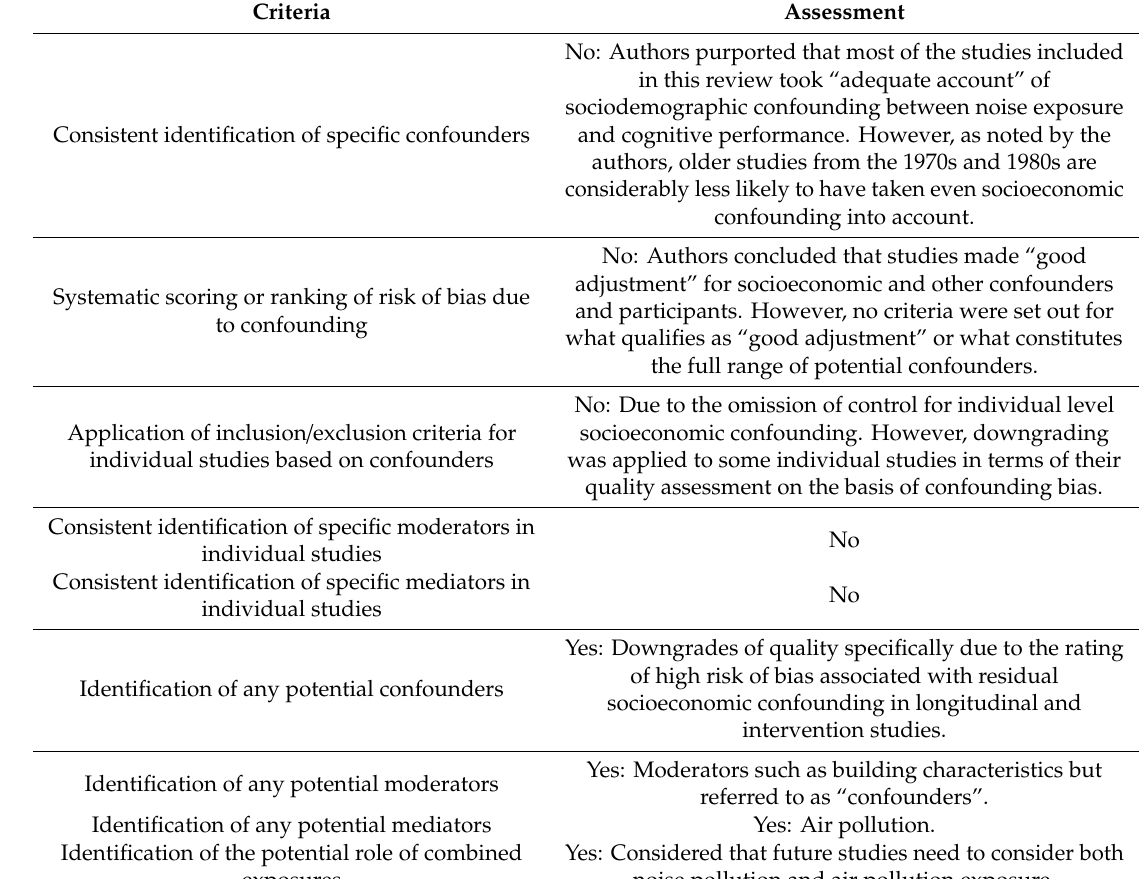
Table 4. Assessment for e ff ects on